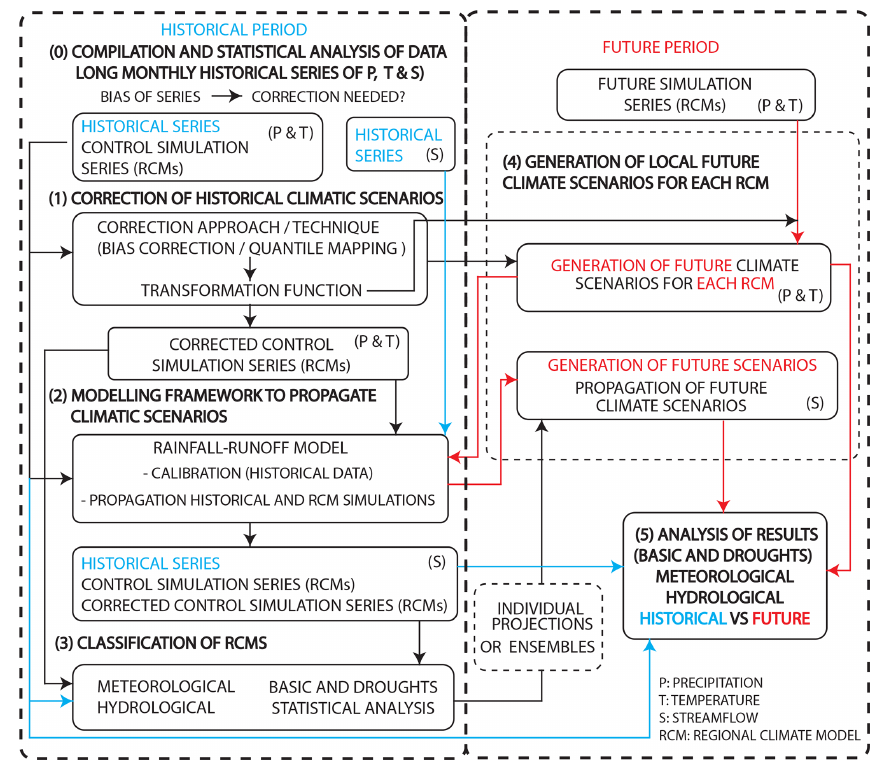
Figure 1. Flow chart of the proposed methodology for the assessment of future meteorological and hydrological